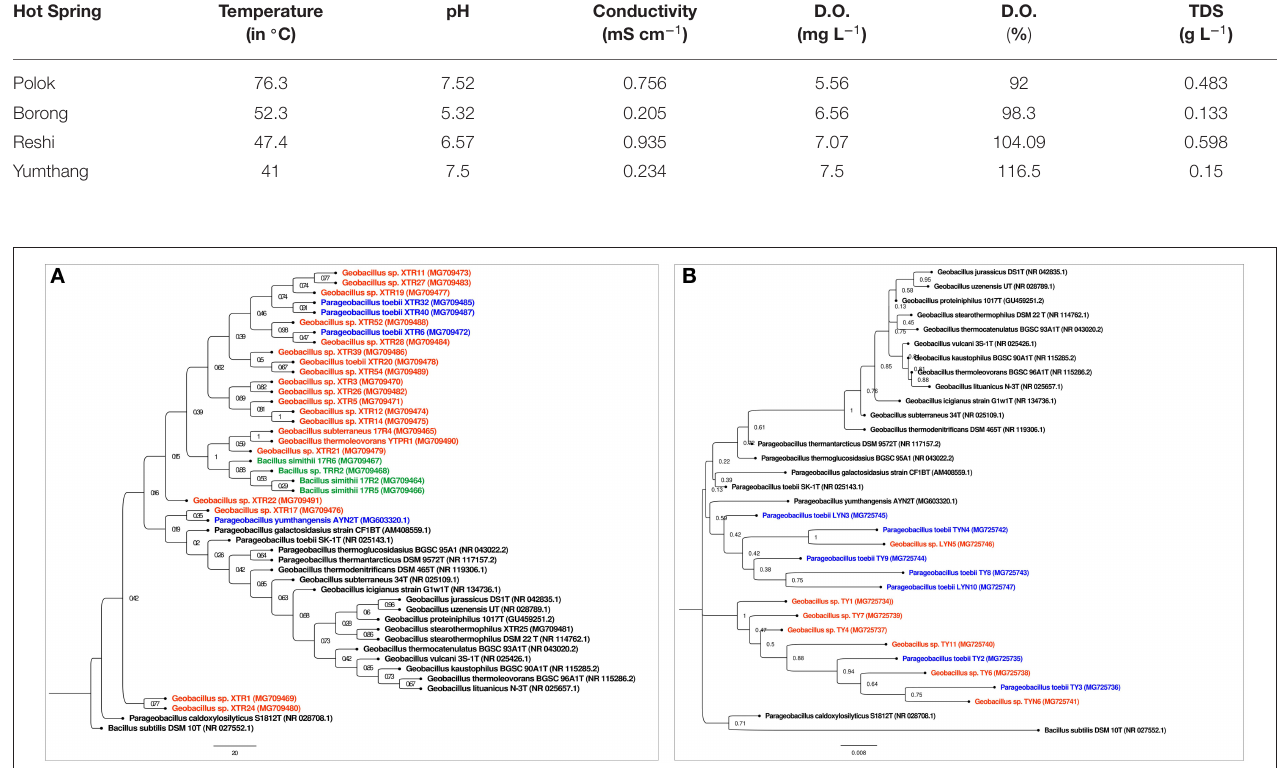
FIGURE 1 | (A) Phylogenetic tree of Reshi isolates: The evolutionary history was inferred using the Maximum Likelihood method. The bootstrap consensus tree inferred from 500 replicates is taken to represent the evolutionary history of the taxa analyzed. The evolutionary distances were computed using the Jukes-Cantor method and are in the units of the number of base substitutions per site. Evolutionary analyses were conducted in MEGA11. Bacillus subtilis DSM 10T (NR 027552.1) was taken as an outgroup. Geobacillus isolates were colored red and Parageobacillus isolates were colored as blue. (B) Phylogenetic tree of Yumthang isolates: The evolutionary history was inferred using the Maximum Likelihood method. The bootstrap consensus tree inferred from 500 replicates is taken to represent the evolutionary history of the taxa analyzed. The evolutionary distances were computed using the Jukes-Cantor method and are in the units of the number of base substitutions per site. Evolutionary analyses were conducted in MEGA11. Bacillus subtilis DSM 10T (NR 027552.1) was taken as an outgroup. Geobacillus isolates were colored red and Parageobacillus isolates were colored as